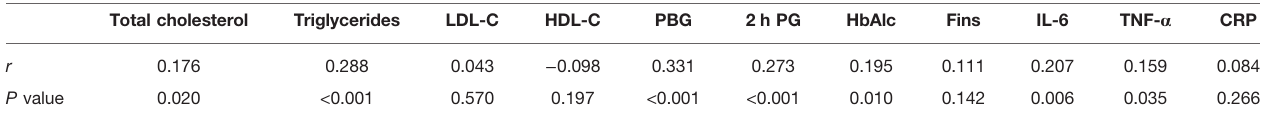
TABLE 3 | Correlation of serum β 2-GPI/oxLDL concentration with blood lipids, blood sugar, and in fl ammatory markers. Total